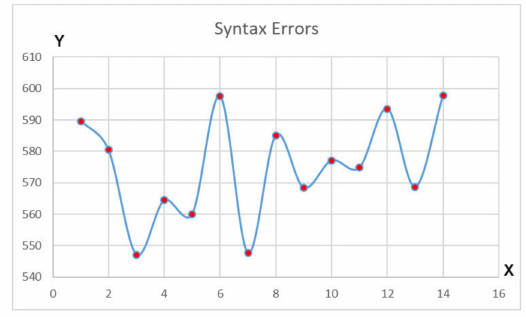
Figure 6. Detected syntax errors with hybrid testing suite during 14 days of experiments; X -axis representing the number of syntax errors; Y -axis representing the number of